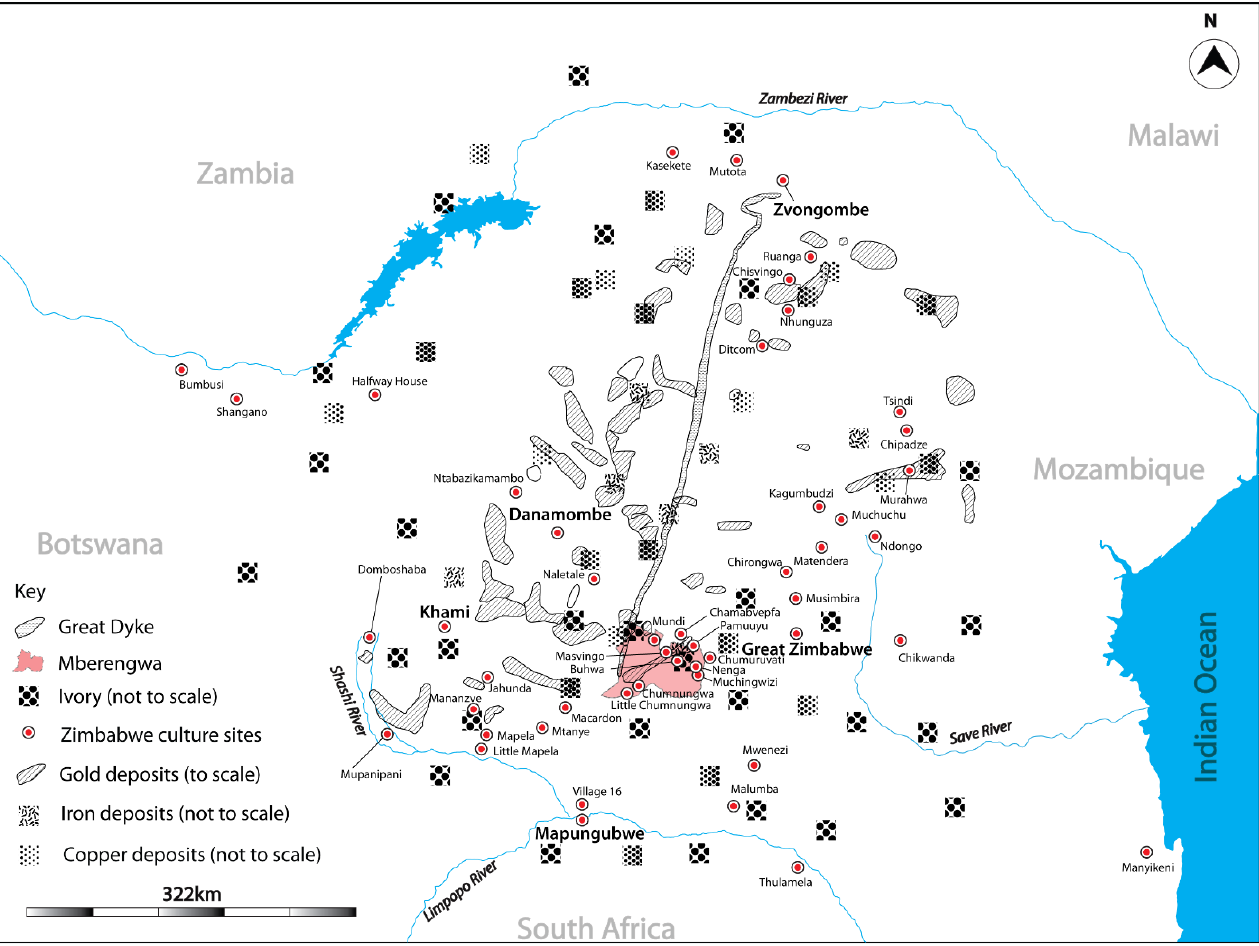
Figure 1. A portion of southern Zambezia—the landscape drained by the Zambezi and Limpopo Rivers. Highlighted is Mberengwa and the other gold ‐ belt territories where gold and other key re ‐ sources were alluded to have been procured by elites who resided in the Zimbabwe culture capitals.